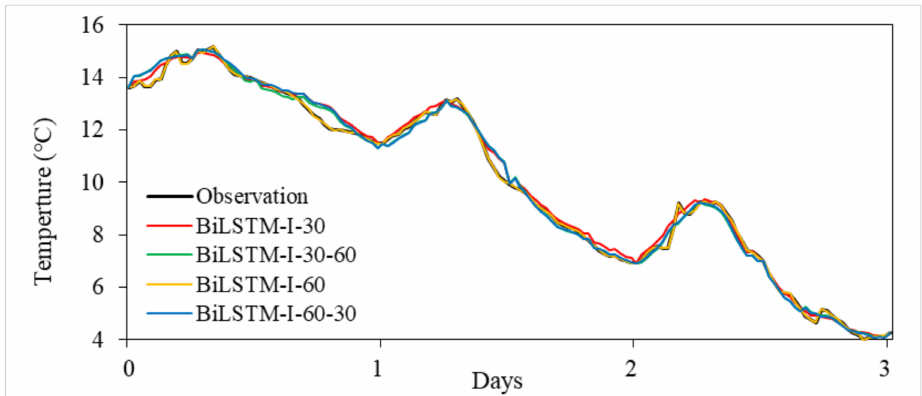
Figure 4. BiLSTM-I model results with 30- and 60-day